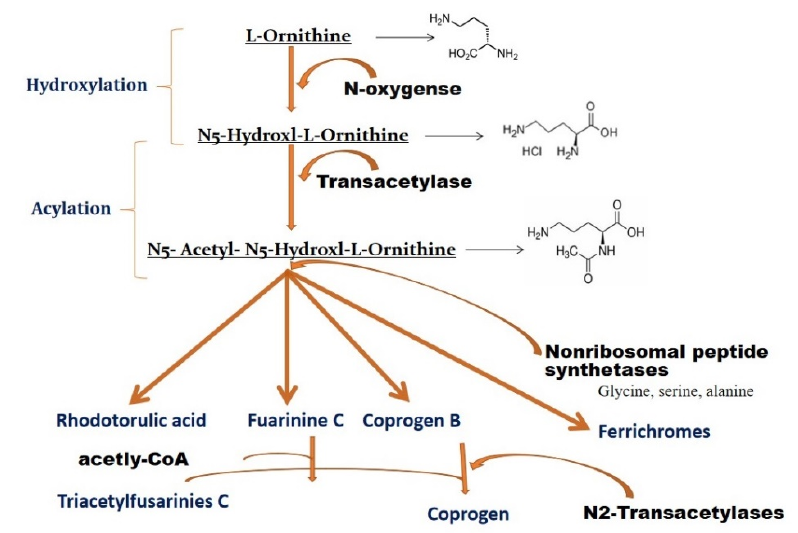
Figure 3. L-ornithine is the biosynthetic precursor of siderophores in fungi. Intermediate steps including hydroxylation, acylation and acetylation lead to the synthesis of Rhodotorulic acid, Fusarinine C and Coprogen (modified and adapted from Philpott [29]).